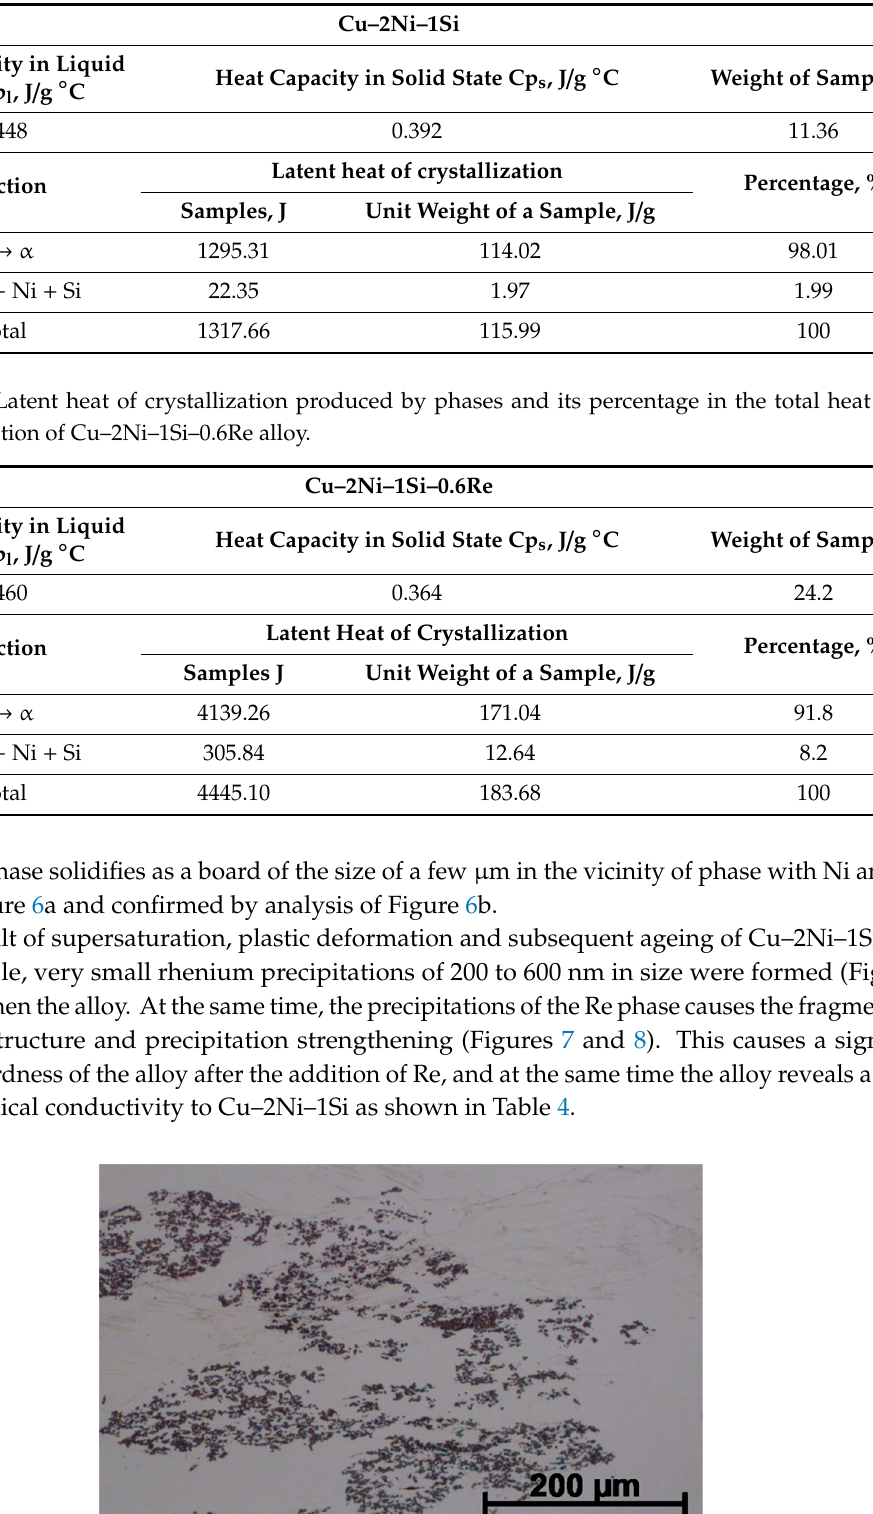
Table 3. Latent heat of crystallization produced by phases and its percentage in the total heat of crystallization of Cu–2Ni–1Si alloy.